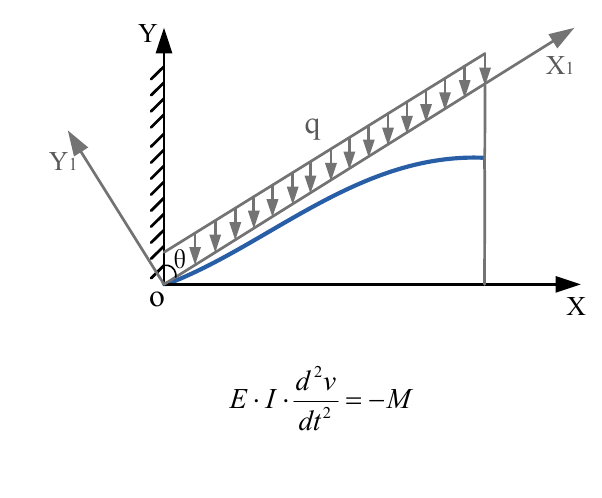
Figure 2. Sketch map of cantilever